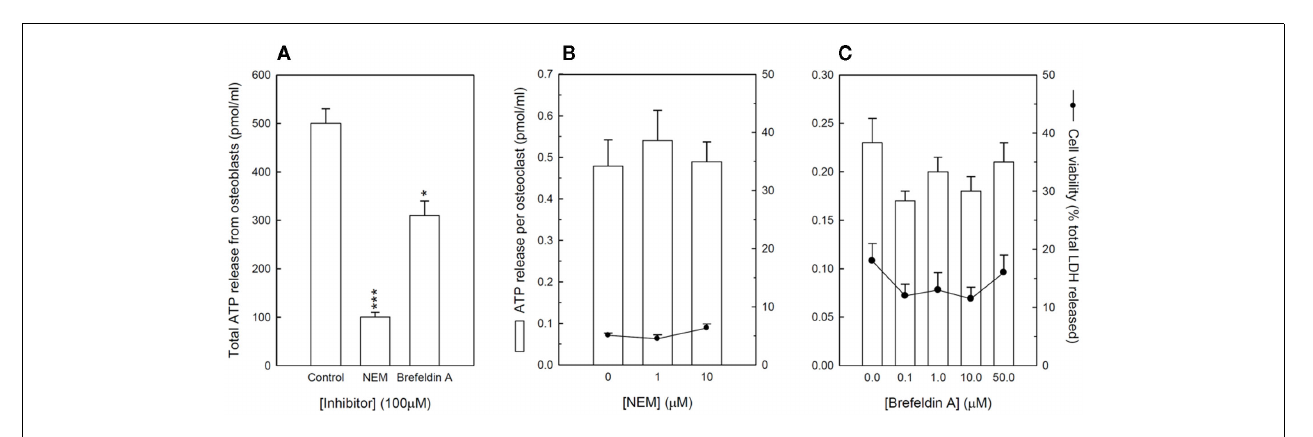
FIGURE 4 | Inhibitors of vesicular exocytosis do not blockATP release from osteoclasts. (A) NEM and brefeldin A (100 μ M) inhibit ATP release from mature osteoblasts by 80 and 40%, respectively. Cells were cultured on dentine disks for 7days before the effect vesicular exocytosis inhibitors on